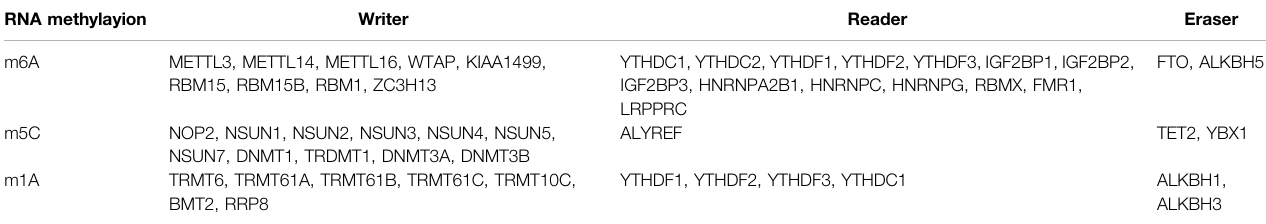
TABLE 1 | RNA methylation-related genes of m 6 A/m 5 C/m 1 A. RNA